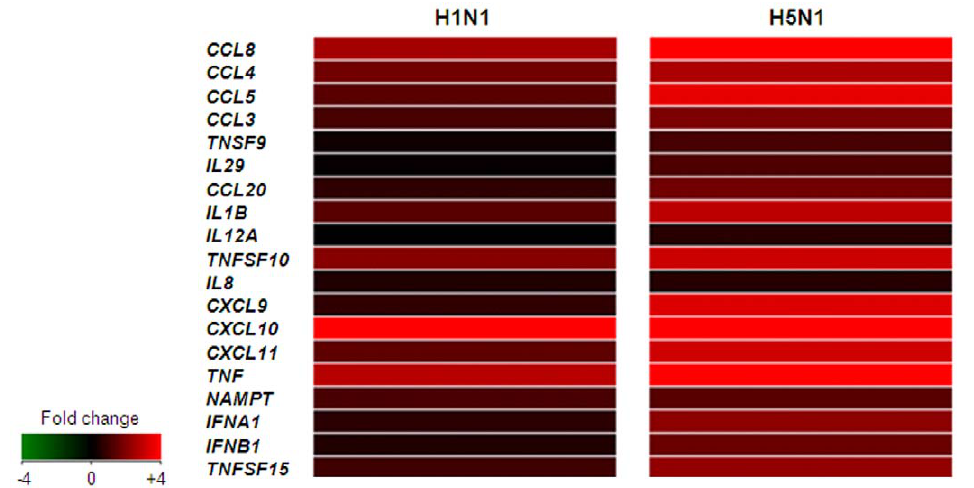
Figure 3. Expression of selected genes annotated are related to cytokine and chemokine activity. Increased gene expression levels were seen in response to H5N1 compared to H1N1 infection.